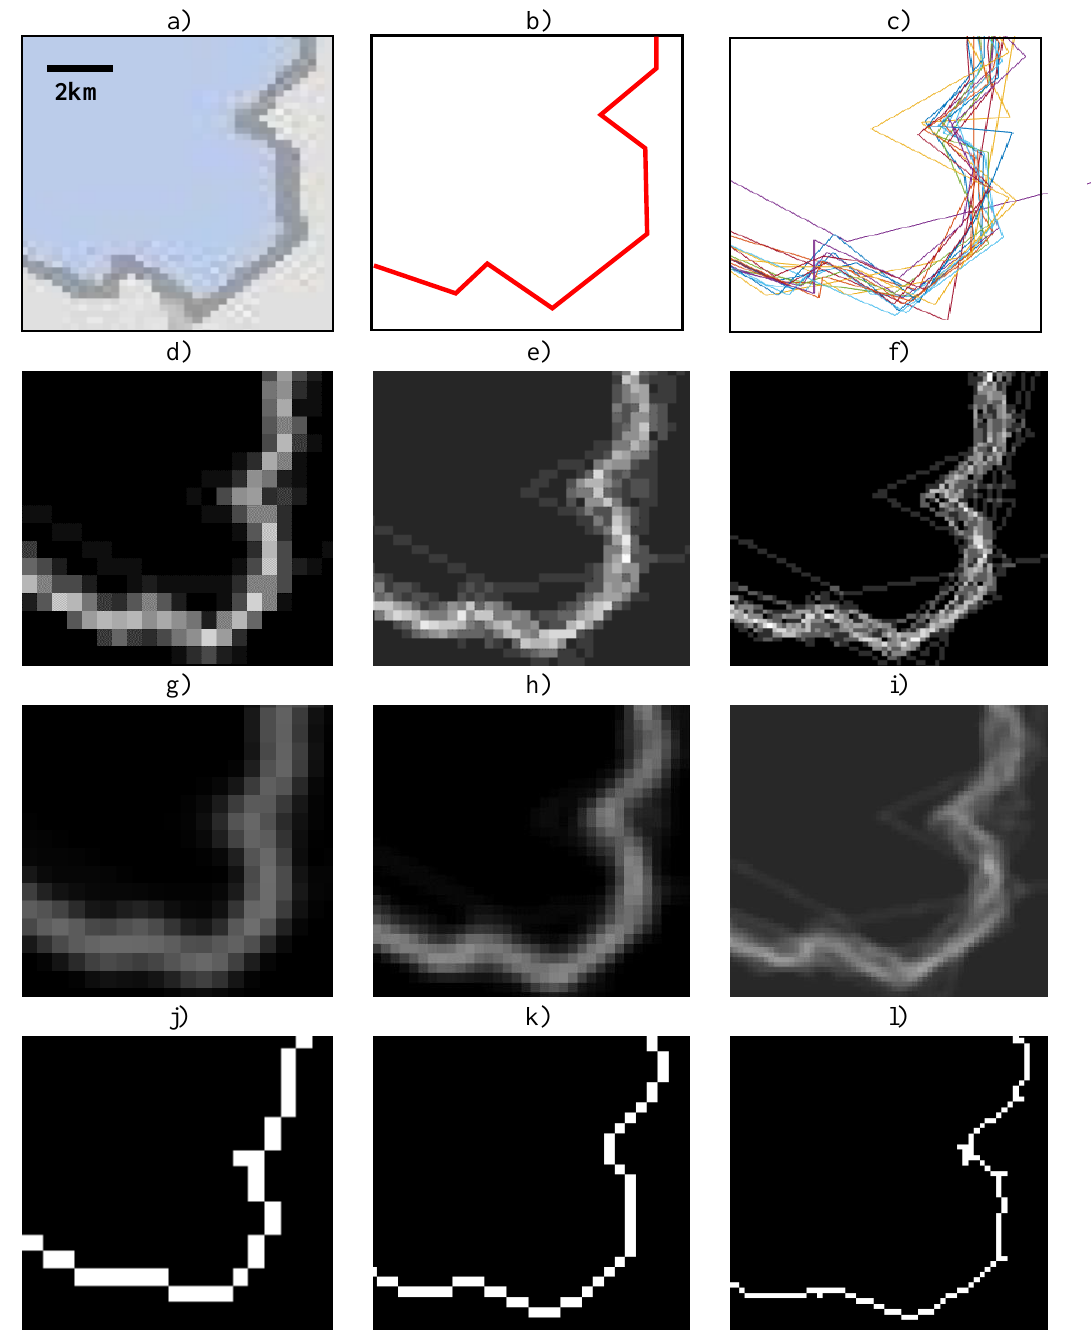
Figure 5. Results of the raster-based integration: (a) data source; (b) reference data; (c) multiple data collection; (d) – (f) raster data before smoothing with raster cell sizes 300m, 150m and 75m (g); raster data after smoothing with a 3x3 Gauss filter with raster cell sizes 300m, 150m and 75m; (j) – (l) skeleton with raster cell sizes 300m, 150m and